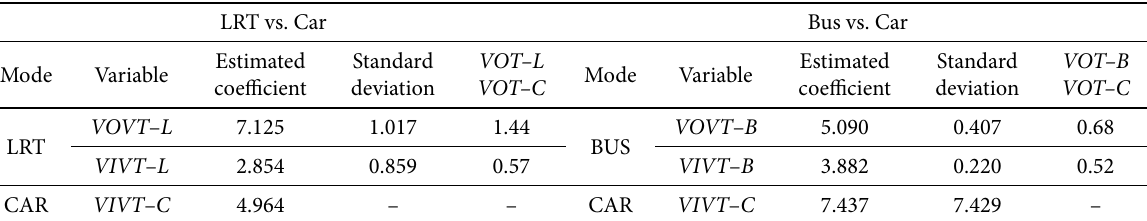
Table 8. Values of time for LRT vs. Car and for Bus vs. Car